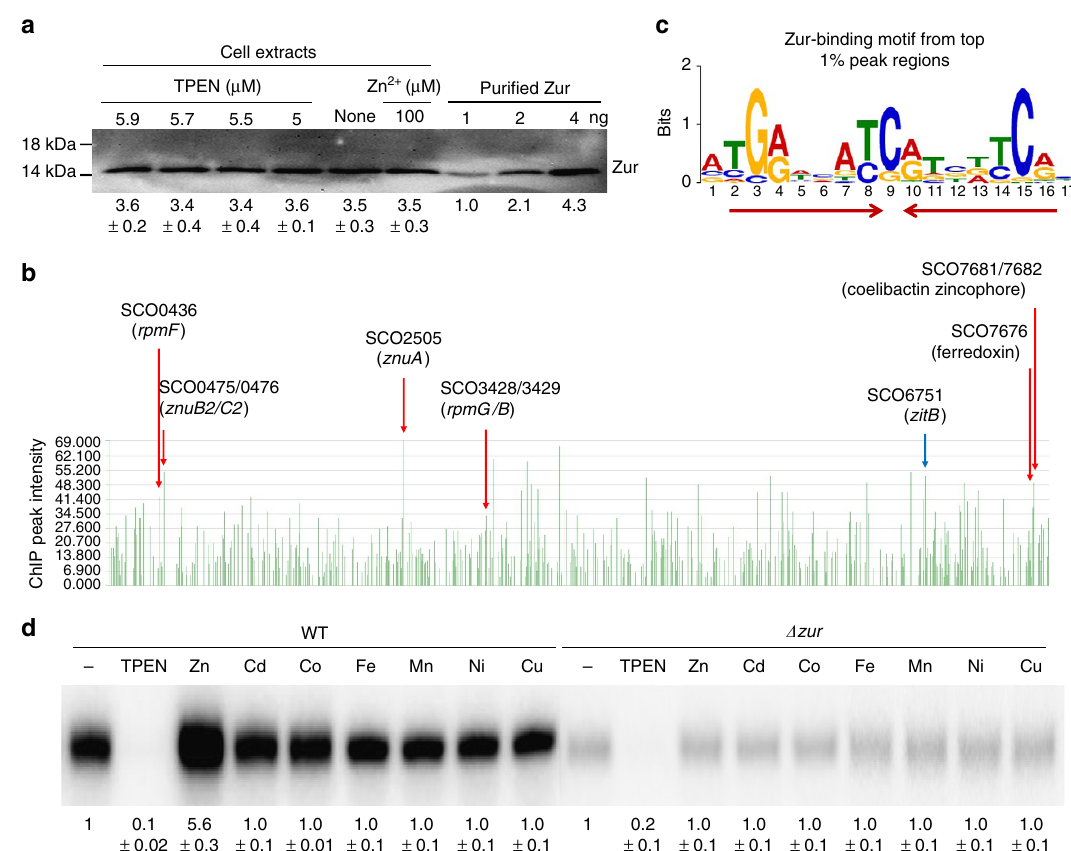
Figure 1 | The abundance of Zur and its genome-wide binding in S. coelicolor . ( a ) Analytical western blot analysis of Zur. Exponentially grown S. coelicolor M145 cells were either untreated or treated with varying concentrations of chelator TPEN (5.9, 5.7, 5.5 and 5.0 m M) or 100 m M ZnSO 4 for 1h before cell harvest. Crude cell extracts were analysed by western analysis, in parallel with quantified amount of purified Zur (1, 2 and 4ng), using polyclonal antibodies against Zur. The amount of Zur in each loaded sample was estimated in ng, taking the band intensity of 1ng purified Zur as 1.0. Average values with s.d.’s from three independent experimental samples were presented. ( b ) Zur-binding peaks throughout the whole genome from ChIP-chip analysis. The peak intensity values ( y axis) were calculated from the average of the log 2 ratios of 10 highest consecutive probe signals for each Zur-enriched site. Known promoter sites of Zur-repressed genes were indicated with red arrows. A new promoter site with Zur-binding consensus sequence was indicated with a blue arrow. ( c ) The Zur binding motif was extracted from the highly enriched 172 Zur-binding regions by multiple EM for motif elicitation (MEME), with E-value of 3.9e-233. ( d ) The zinc-specific and Zur-dependent induction of the zitB gene. Transcripts from SCO6751 ( zitB ) gene were analysed by S1 mapping. Exponentially grown wild type (WT) and D zur mutant cells were treated with 6 m M TPEN or various metal salts (ZnSO 4 , CdCl 2 , CoSO 4 , FeSO 4 , MnCl 2 , NiSO 4 and CuSO 4 ) at 100 m M for 30min before cell harvest. The amount of zitB transcript was quantified and presented in relative value with that in non-treated sample as 1.0. Values from three independent experiments were presented as average with s.d.’s. The P values for all the measurements